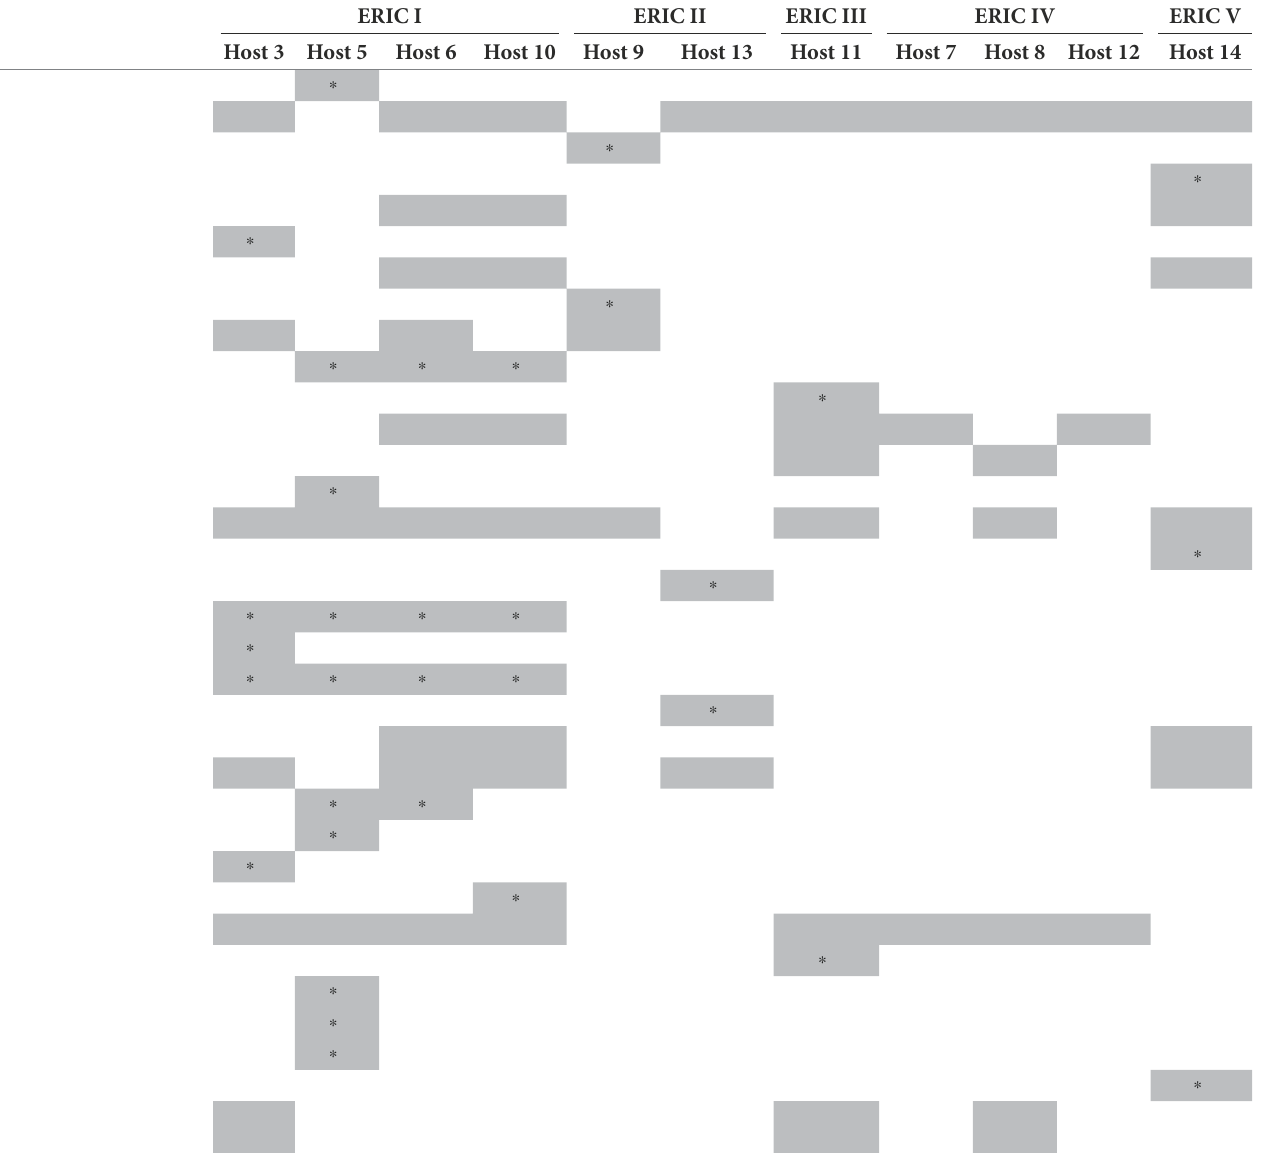
YncE family protein YxeA family protein Coat protein Iron-containing alcohol dehydrogenase Ketopantoate hydroxymethyltransferase Membrane protein Outer spore coat protein (CotE) Spore protease YyaC Sporulation protein YhbH Stress protein DNA mismatch repair protein MutS ERF superfamily protein Acetyltransferase dCMP deaminase family protein Murein transglycosylase-like protein NTP-binding protein Peptidase domain Phenylalanine racemase Phosphatidylglycerophosphatase A (PgpA) Phosphatidylserine decarboxylase STAS-like domain-containing protein Thiamin pyrophosphokinase Thioredoxin reductase YqaE/Pmp3 family membrane protein The gray color identifies the corresponding CDS in the respective ERIC genotype. * CDS only found in this